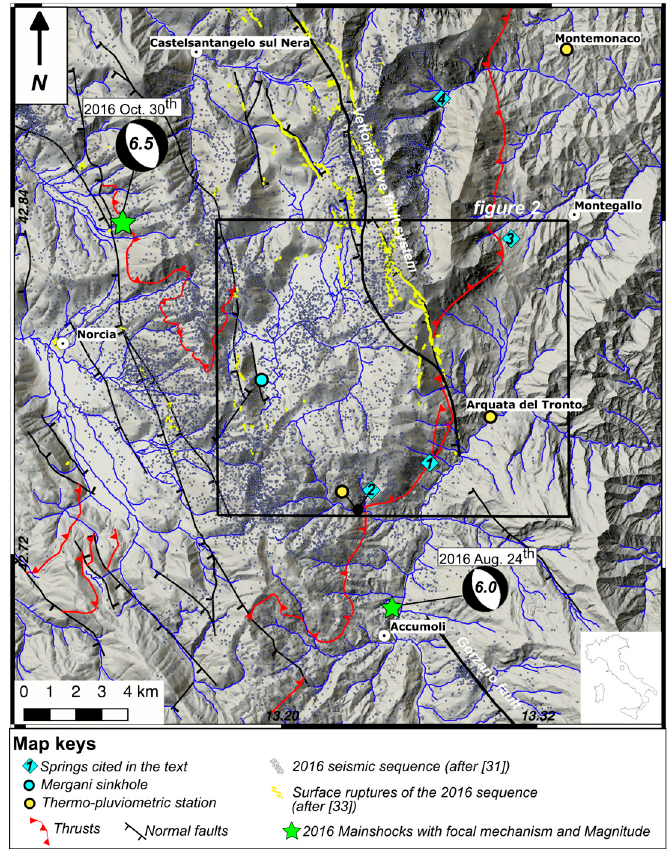
Figure 1. Area affected by the seismic crisis in 2016. Green stars represent the M w ≥ 6.0 mainshocks, and dark grey dots are all the earthquakes recorded during the seismic sequence.